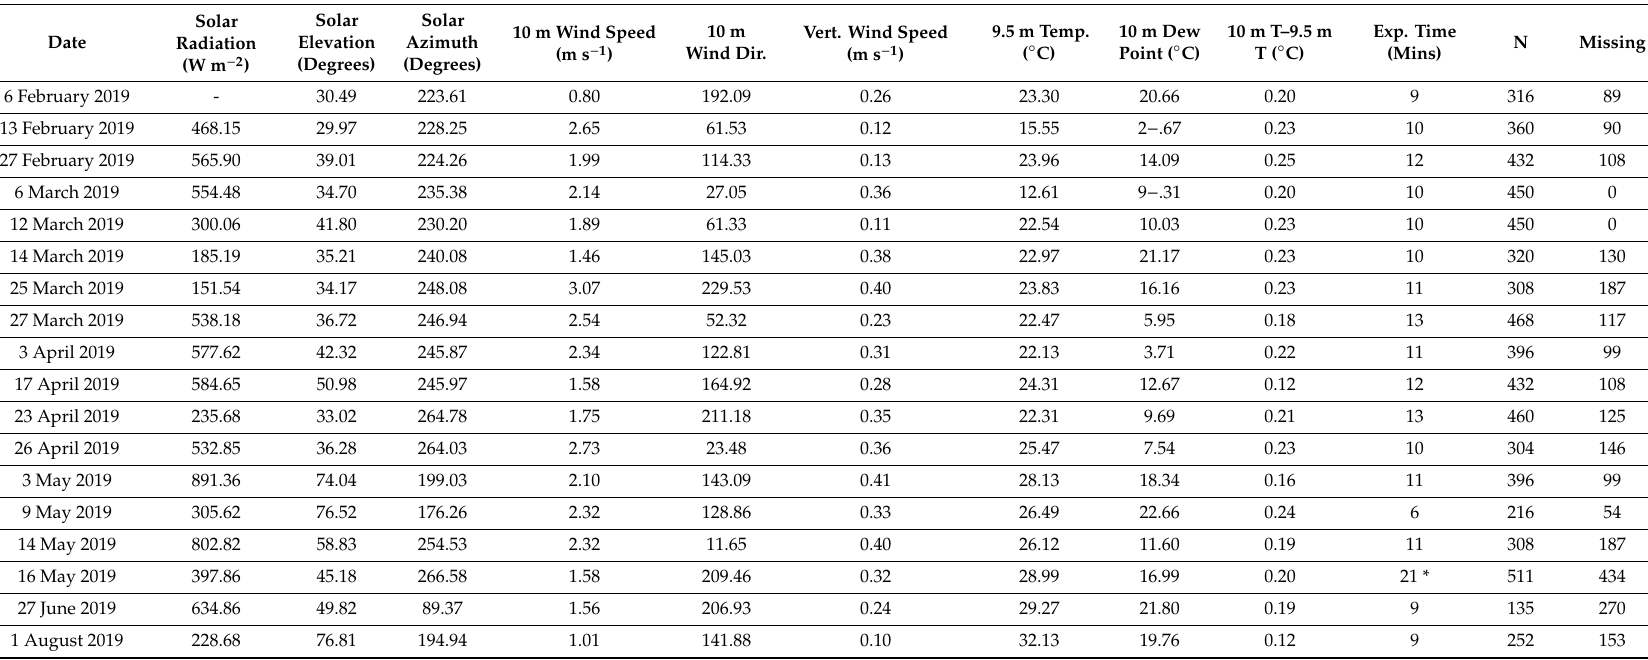
Table 3. Ten meter flight experiments by date with the solar conditions and meteorological conditions from the South Alabama Mesonet tower, as well as the experiment times averaged over the length of the experiment. The experiment duration, the sample size (N), and the missing values are also listed. * On 16 May 2019, the two experiments were flown back to